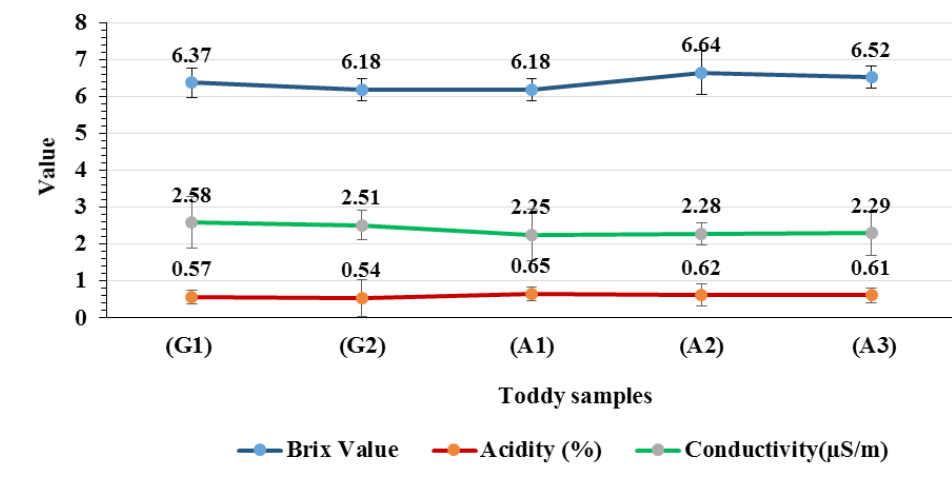
Figure 1: °Brix, acidity and conductivity in Toddy